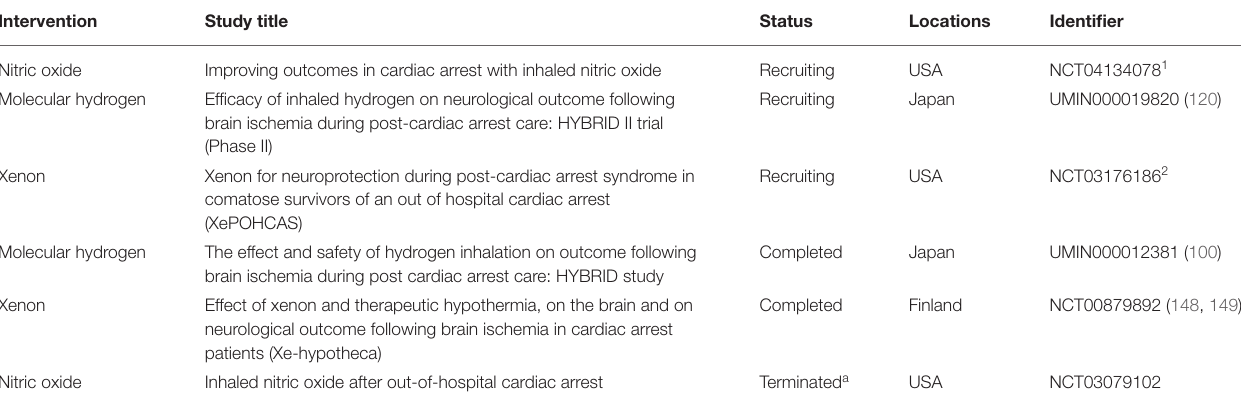
TABLE 1 | Summary table of the past and current clinical trials on inhaled gases as therapies for PCAS (as of 1st, Dec, 2020).